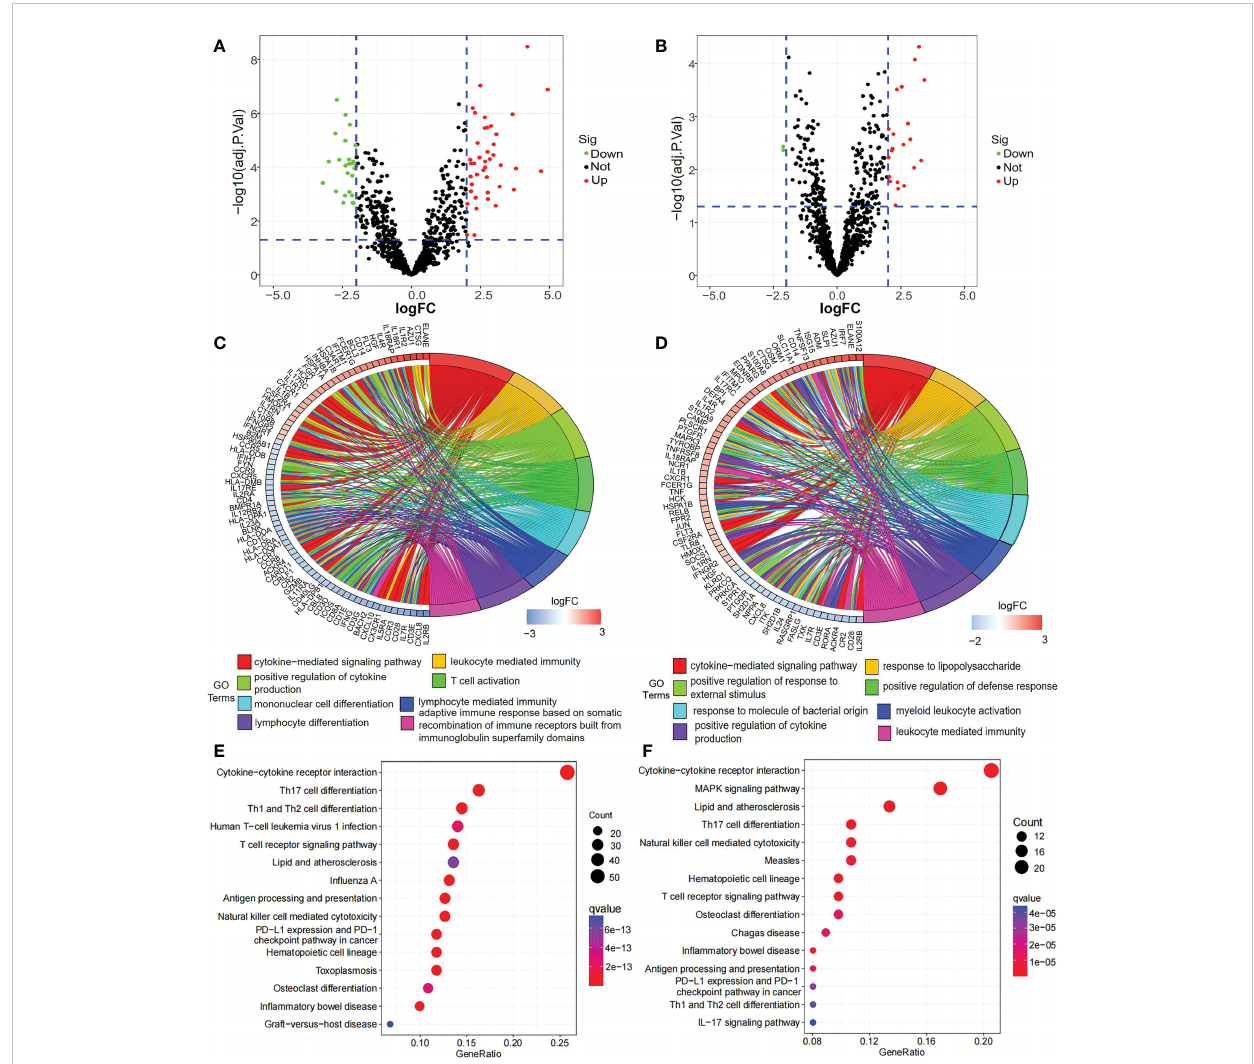
FIGURE 5 DEIGs and their enrichment analysis. (A) Volcano plot of DEIGs between the AIS A grade of SCI and the HC group. (B) Volcano plot of DEIGs between the AIS D grade of SCI and the HC group. (C) GO functional enrichment analysis of DEIGs between the AIS A grade of SCI and the HC group. (D) GO functional enrichment analysis of DEIGs between the AIS D grade of SCI and the HC group. (E) KEGG enrichment analysis of DEIGs between the AIS A grade of SCI and the HC group. (F) KEGG enrichment analysis of DEIGs between the AIS D grade of SCI and the HC group. SCI, spinal cord injury; HC, healthy uninjured control; DEIGs, differentially expressed immune-related genes; GO, Gene Ontology; KEGG, Kyoto Encyclopedia of Genes and Genomes; AIS, American Spinal Cord Injury Association Impairment